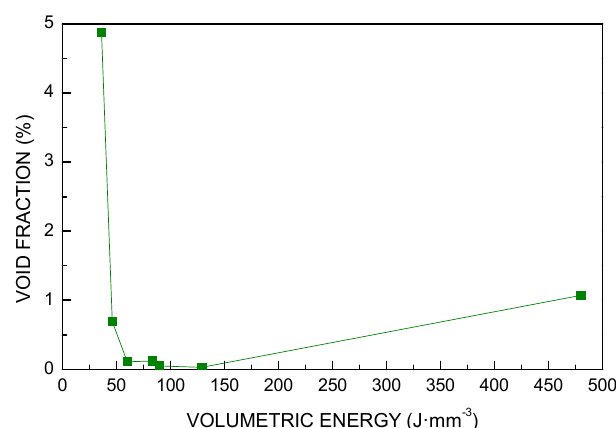
Figure 7. Size of pores as a function of VED .